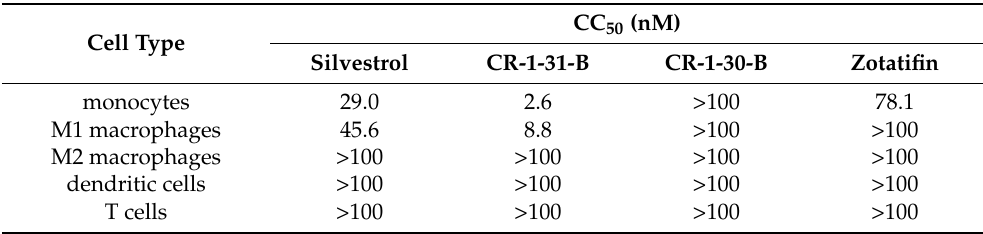
Figure 4. Effects of rocaglates on immune cell viability. Percentage of viable human monocytes, M1/M2 macrophages, MdDCs and T cells in the presence or absence of different concentrations of silvestrol, CR-1-31-B, zotatifin, the inactive enantiomer CR-1-30-B or DMSO control determined by Orangu assay in triplicates. Error bars show SEM with n ≥ 3. Table 1. Overview of cytotoxic concentration 50 (CC 50 ) of the indicated compounds in corresponding cell